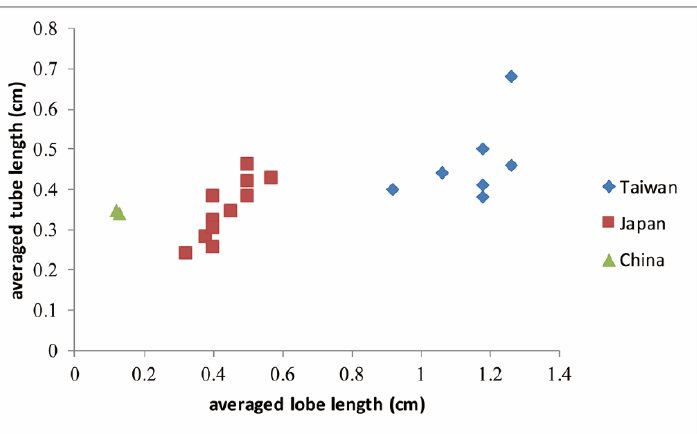
Figure 9. Corolla tube versus lobe length measured from C. ramondioides flowers distributed in China, Taiwan, or Japan.